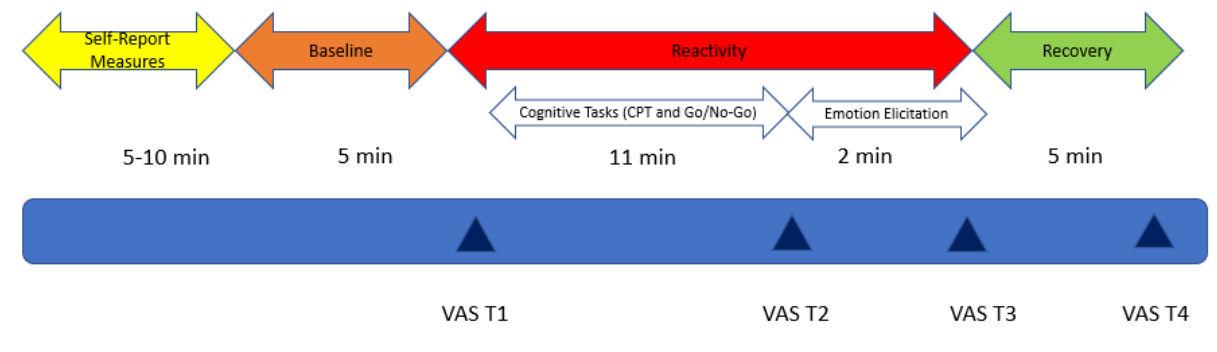
Figure 2. Experiment timeline. CPT: Continuous Performance Task; VAS: Visual Analogue